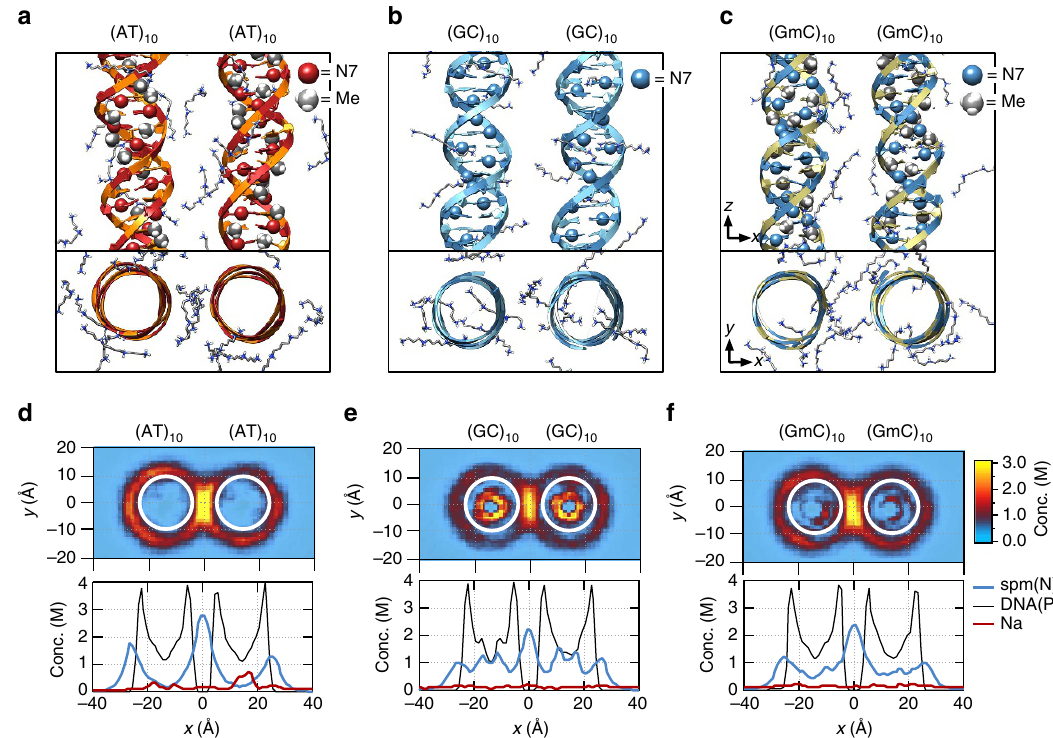
Figure 2 | Molecular mechanism of polyamine-mediated DNA sequence recognition. ( a – c ) Representative configurations of Sm 4 þ molecules at the DNA–DNA distance of 28Å for the (AT) 10 –(AT) 10 ( a ), (GC) 10 –(GC) 10 ( b ) and (GmC) 10 –(GmC) 10 ( c ) DNA pairs. The backbone and bases of DNA are shown as ribbon and molecular bond, respectively; Sm 4 þ molecules are shown as molecular bonds. Spheres indicate the location of the N7 atoms and the methyl groups. ( d – f ) The average distributions of cations for the three sequence pairs featured in a – c . Top: density of Sm 4 þ nitrogen atoms ( d ¼ 28Å) averaged over the corresponding MD trajectory and the z axis. White circles (20Å in diameter) indicate the location of the DNA helices. Bottom: the average density of Sm 4 þ nitrogen (blue), DNA phosphate (black) and sodium (red) atoms projected onto the DNA–DNA distance axis ( x axis). The plot was obtained by averaging the corresponding heat map data over y ¼ [ (cid:3) 10, 10] Å. See Supplementary Figs 4 and 5 for the cation distributions at d ¼ 30, 32, 34 and